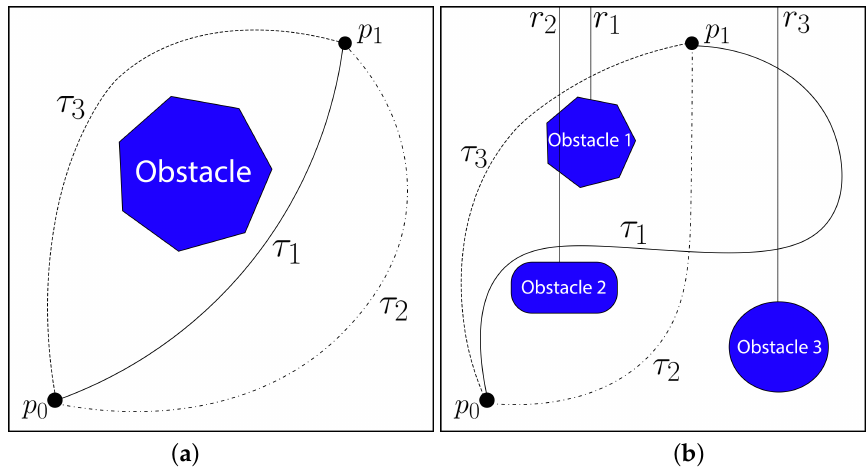
Figure 2. ( a ) three example paths from p 0 to p 1 . Paths τ 1 and τ 2 are homotopic to each other and therefore lie in the same homotopy class, while τ 3 in in a different homotopy class; ( b ) three example paths from p 0 to p 1 . h-signature of τ 1 is r 2 r 3 r − 1 which reduces to r 2 , h-signature of τ 2 is 0, 3 and h-signature of τ 3 is r 2 r 1